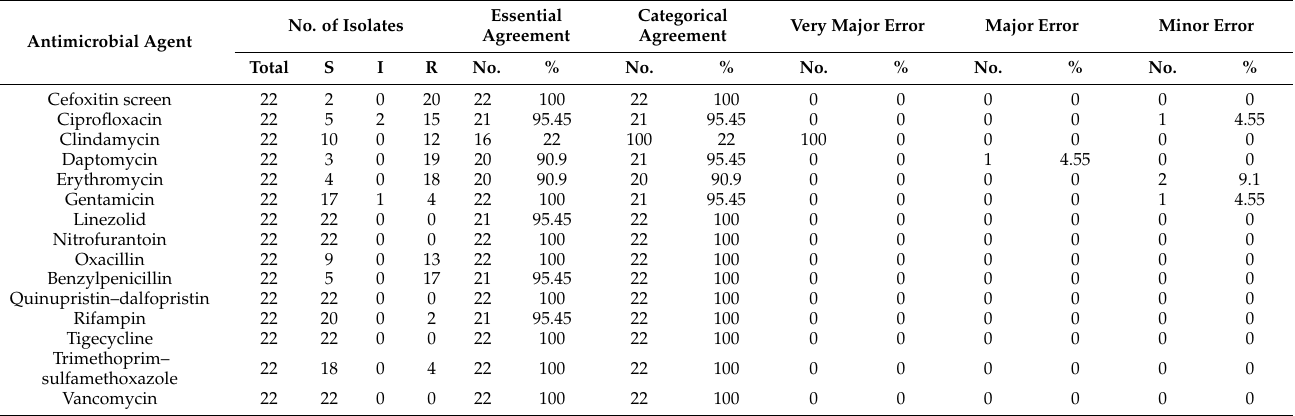
Table 3. Presentation of AST-GP71 card for MRSA. Vitek 2 Compact AST-GP71 cards were used to determine the susceptibility of MRSA recovered from patients suffering from DFIs to antimicrobial